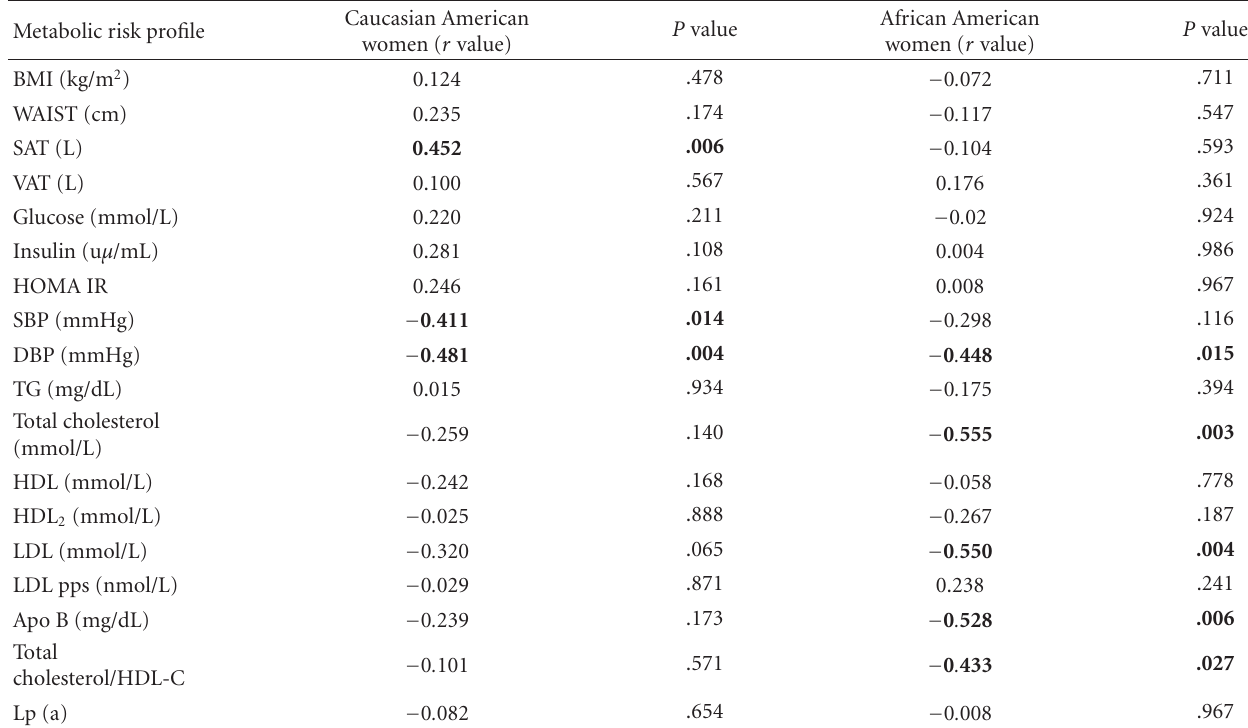
Table 2: Pearson’s correlation coe ffi cients between total testosterone (square root) and the metabolic risk profile after adjusting for age. Metabolic risk